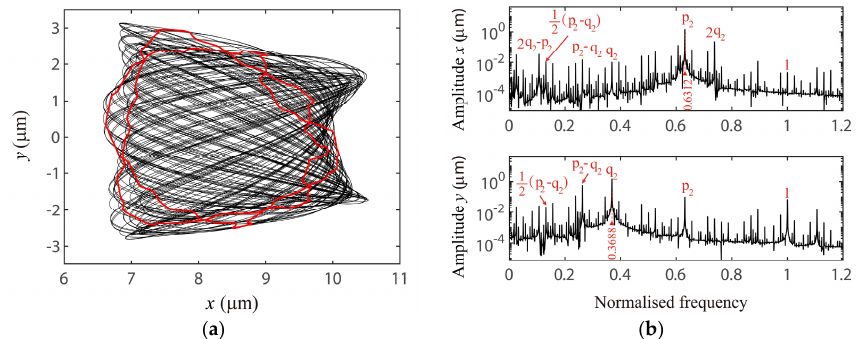
Figure17. For δ 0 = 4.0 µ m, responsecharacteristicsoftheVCquasi-periodmotion(thetori-doublingcase) when Ω = 363 rad / s, ( a ) orbit (black line) and its Poincare mapping (red dots), ( b ) frequency